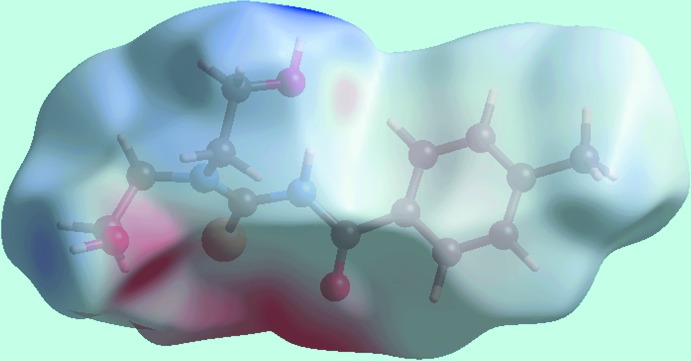
A view of the Hirshfeld surface mapped over the calculated electrostatic potential for (I). The red and blue regions represent negative and positive electrostatic potentials, respectively. The potentials were calculated using the STO-3G basis set at Hartree–Fock level of theory over a range of ±0.18 atomic units.